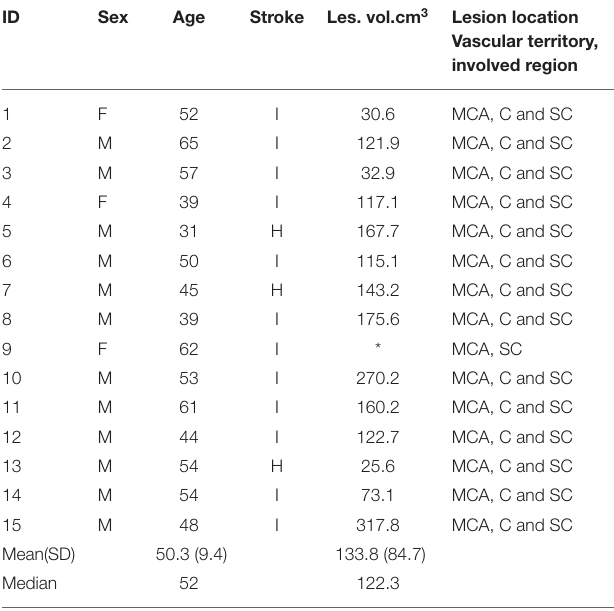
TABLE 2 | Participant characteristics and lesion descriptives ( n =